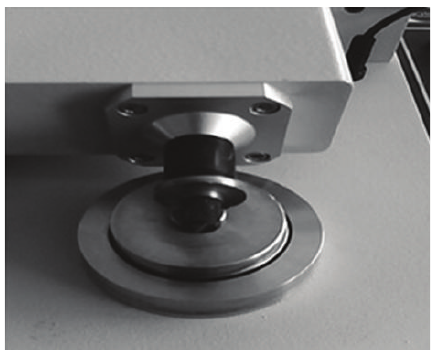
Figure 2: Dimpling process.